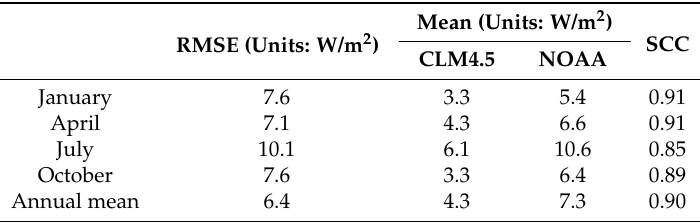
Table 1. The root mean square errors (RMSEs), means and spatial correlation coefficients (SCC) for global Ec in January, April, July, and October and annual